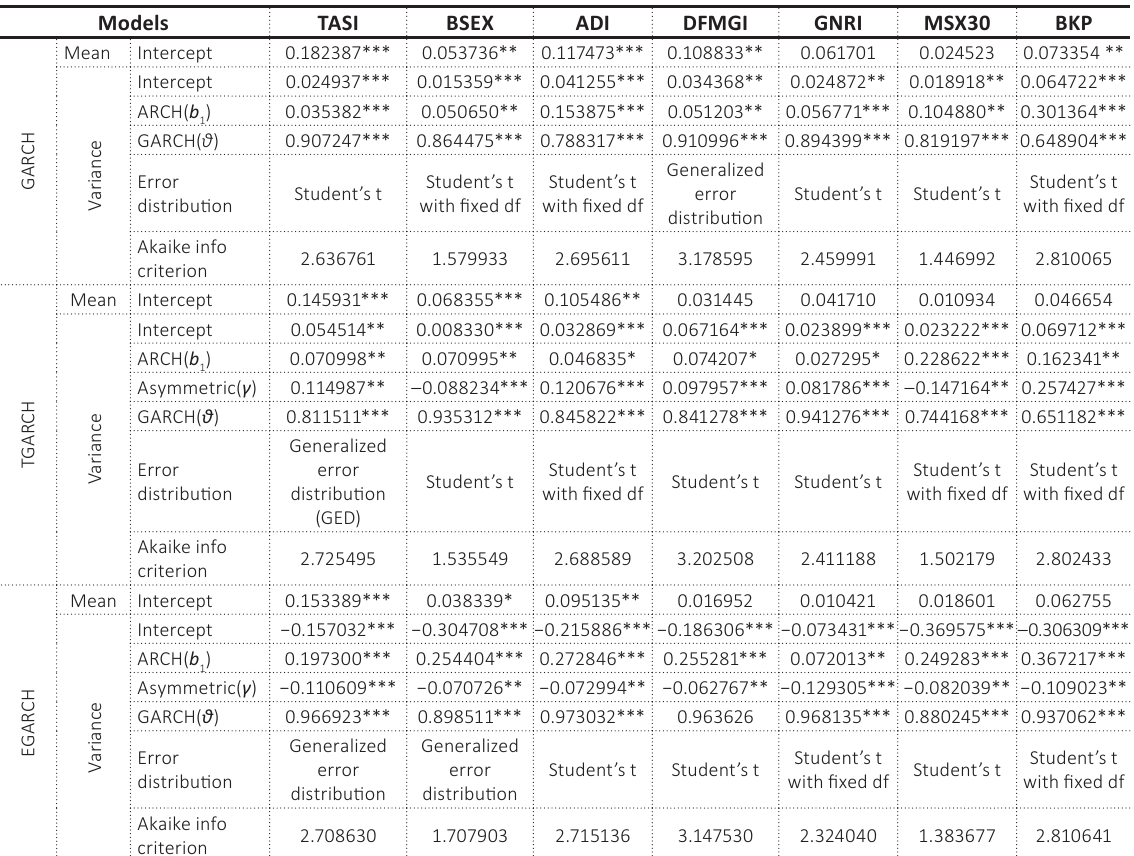
Table 8. TGARCH and EGARCH